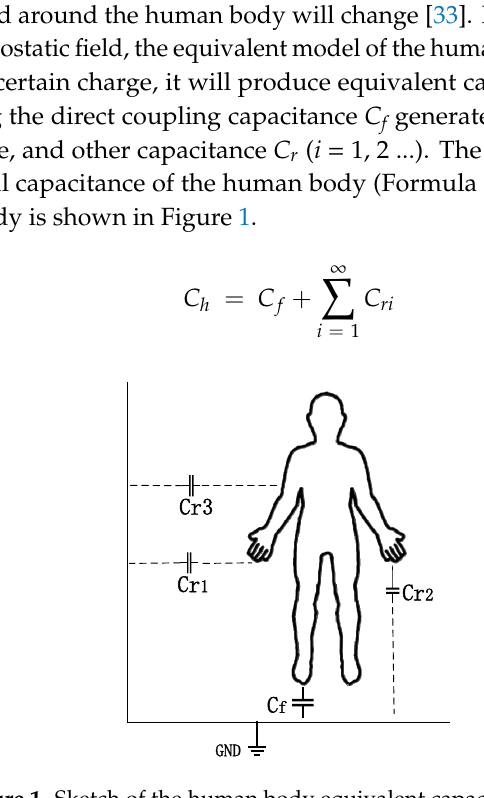
Figure 1. Sketch of the human body equivalent capacitance model.